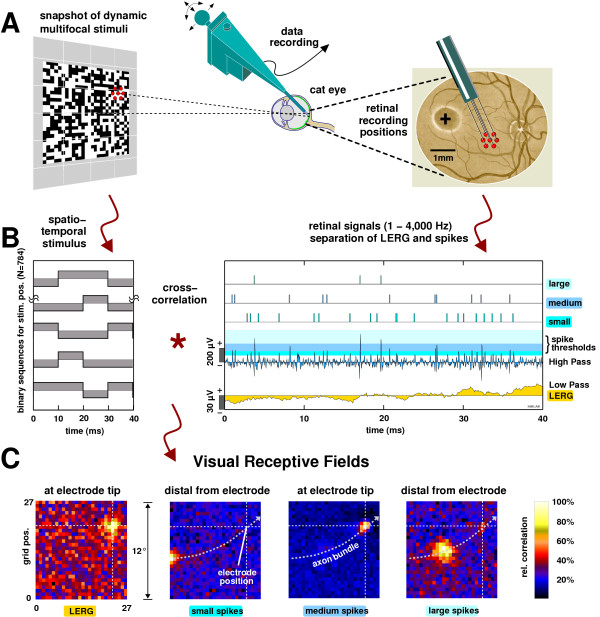
Setup for the analysis of retinal RFs. A: The dynamic multifocal visual stimulus was presented on a computer monitor 1.3 m in front of the cat. Retinal signals were recorded by epiretinally positioned electrodes. B: Spikes were extracted from high-pass filtered (0.5–1 kHz) broadband data using an amplitude thresholding approach. LERG and spike signals were cross-correlated with the binary stimulus sequences at all pixel positions (N = 784). C: Example RF maps for the four signals separated from one electrode recording shown in B. White crosshairs indicate the back-projected epiretinal electrode positions that served as reference points for the RF centers. Crosscorrelation values for a 25 ms time delay between stimulus and response are color-coded for each signal separately (dark blue: weak or negative correlation, light yellow: strong positive correlation). The polarity of the LERG-RF is reversed to ease its comparison to the spike-RFs. Note that in this example the neurons responsible for LERG and the medium sized spikes both have RF centers that are congruent with the position of the electrode tip. The neurons responsible for small and large sized spikes, however, have RF centers that are clearly shifted by several degrees of visual angle. All RFs are of ON-type in this example. (Data from experiment 302, right eye)